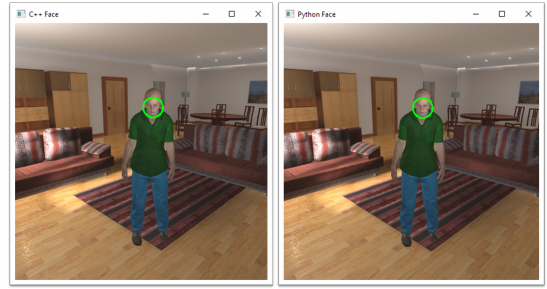
Figure 8. Face detection results in C++ and